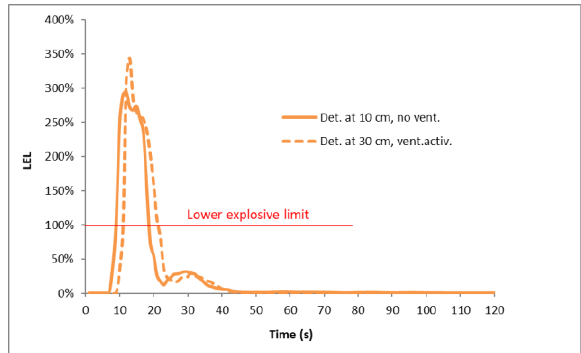
Figure 12. LPG concentration close to the emission source for 6-mm gap (measurement point No. 1R).